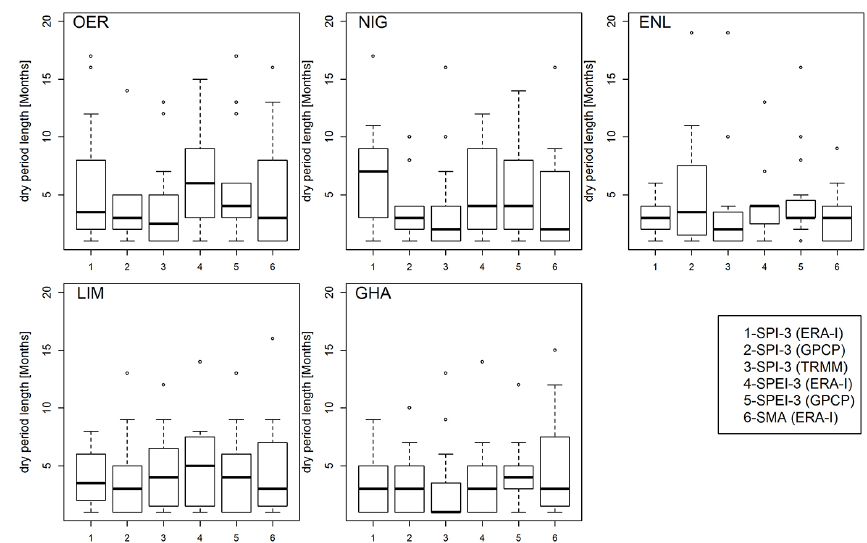
Fig. 7. Duration of dry periods for the standardized indicators below zero in the common period 1998–2010. OER: Oum er-Rbia, NIG: Inner Niger Delta, NIL: Eastern Nile, LIM: Limpopo Basin and GHA: Great Horn of Africa. Dashed lines extend from 5th to 95th percentile of estimations, boxes extend from 25th to 75th percentile and middle horizontal lines within each box indicate the mean for each